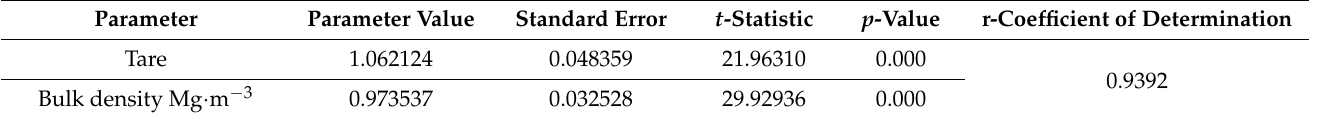
Table 7. Evaluation of model parameters for the bulk volume of the sawdust load.